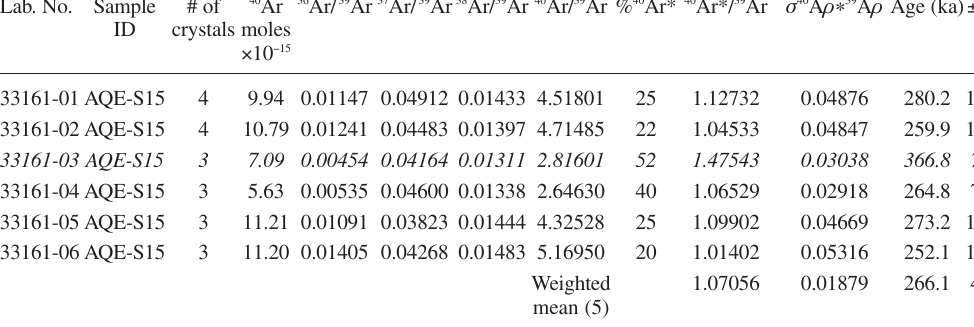
Table II. 40 Ar/ 39 Ar dating for the studied pumice layer. Lab. No.